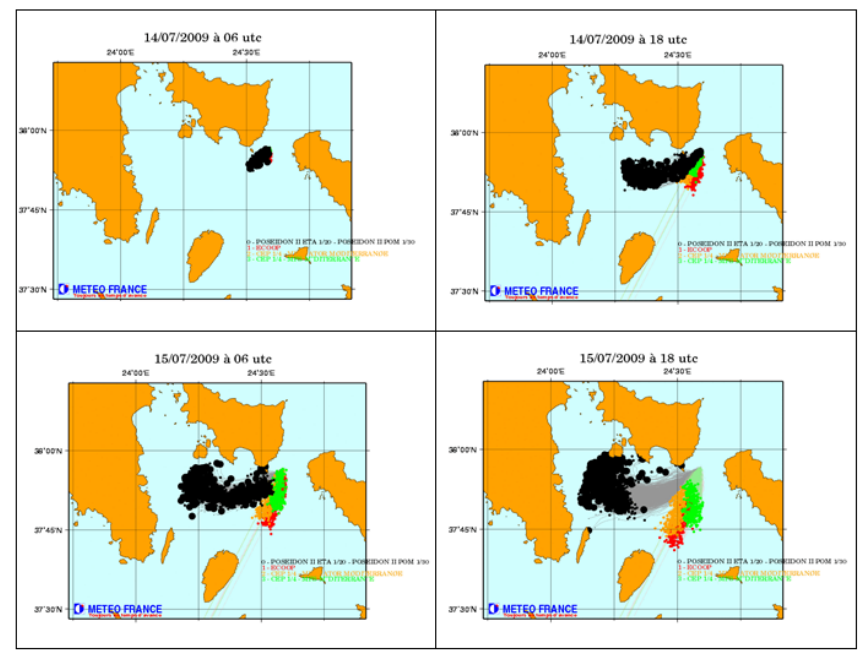
Fig. 9. Simulation of oil spill evolution of the same hypothetical accident as in Fig. 8. The oil slick drift computed by Aegean DeSS is presented in black (forcing data provide by POSEIDON models, atmospheric resolution 1/20 ◦ , oceanographic and waves 1/30 ◦ ). The three computed cases by Meteo France are presented in red, orange and green according to the forcing data: ECMWF (1/4 ◦ )+climatologic currents (in red); ECMWF (1/4 ◦ )+Mercator currents (1/12 ◦ ) (in orange); ECMWF (1/4 ◦ )+MFS currents (1/12 ◦ ) (in green). Graphics produced by Meteo France.